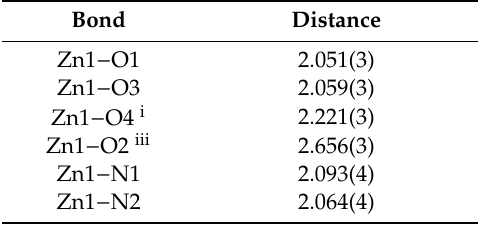
Table 5. Bond lengths to the Zn(II) ion (Å) for ( 5